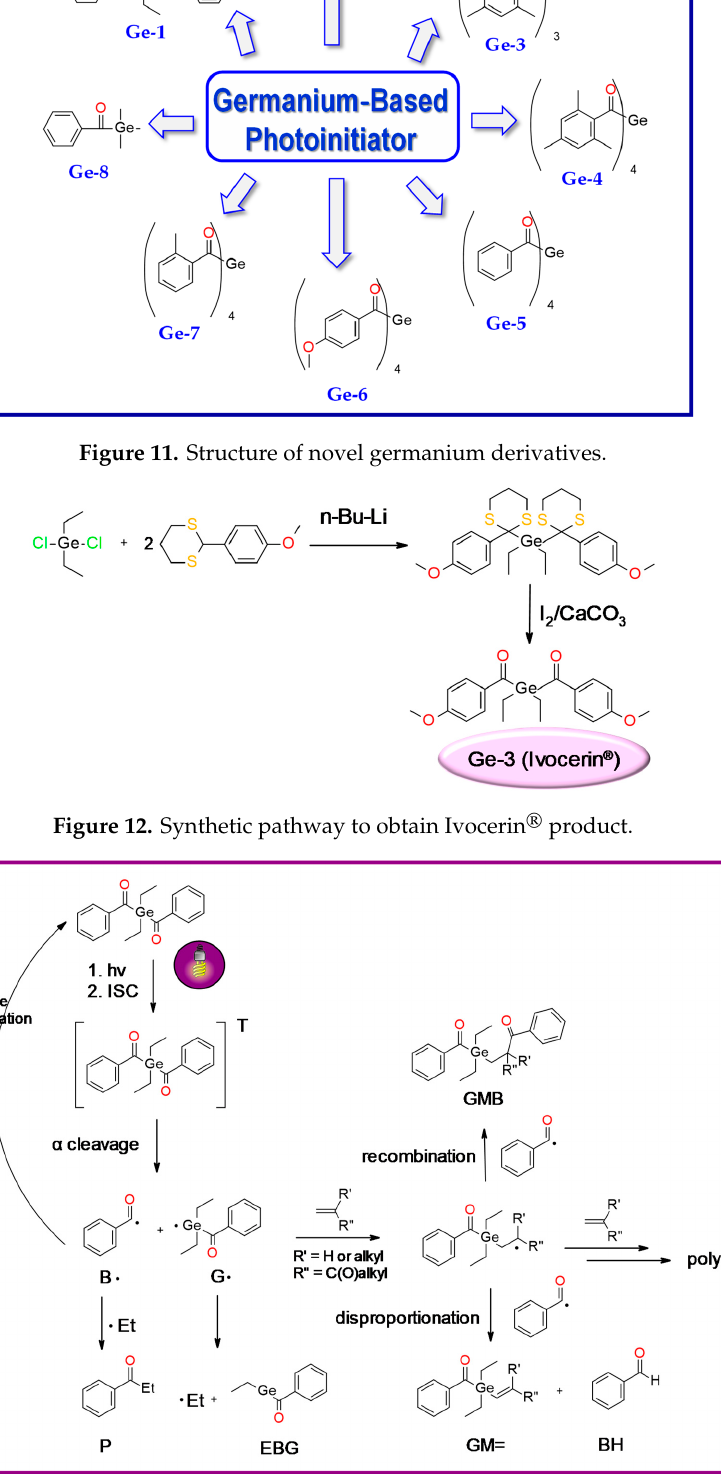
Figure 13. Proposed reaction mechanism of germanium derivatives as a photoinitiator in the presence of monomers. of